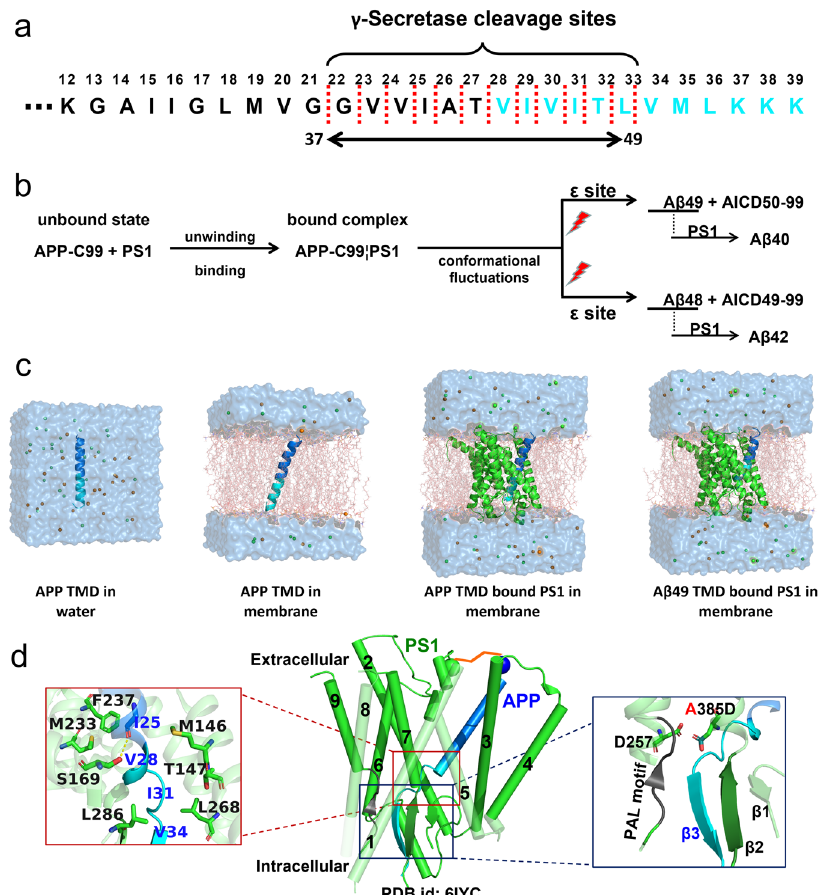
Fig. 1 Overview of MD simulation systems. a Sequence overview of A β 49 APP TMD and successive cleavage sites for A β 37-49 production, the 12 C-terminal residues of APP TMD are highlighted in cyan. b The proposed process of APP C99 cleavage by γ -secretase for the production of a series of A β s. c Simulation systems were used to investigate the dynamic and thermodynamic properties of APP TMD (in blue) recognized by PS1 (in green) of γ - secretase, including APP TMD solvated in the water environment, APP TMD embedded in the membrane environment, APP TMD bound to PS1, and A β 49 TMD bound to PS1. d Enzyme-substrate interaction between APP TMD and PS1 of γ -secretase with key residues of PS1 involved in the interaction with unwound APP highlighted. The PAL motif (P433-A434-L435) and two β sheets ( β 1 and β 2) from PS1 stabilize the APP β sheet via the hybrid anti- β sheet formation. The mutation A385 for the experimental structure determination is restored as D385 in the simulation systems.